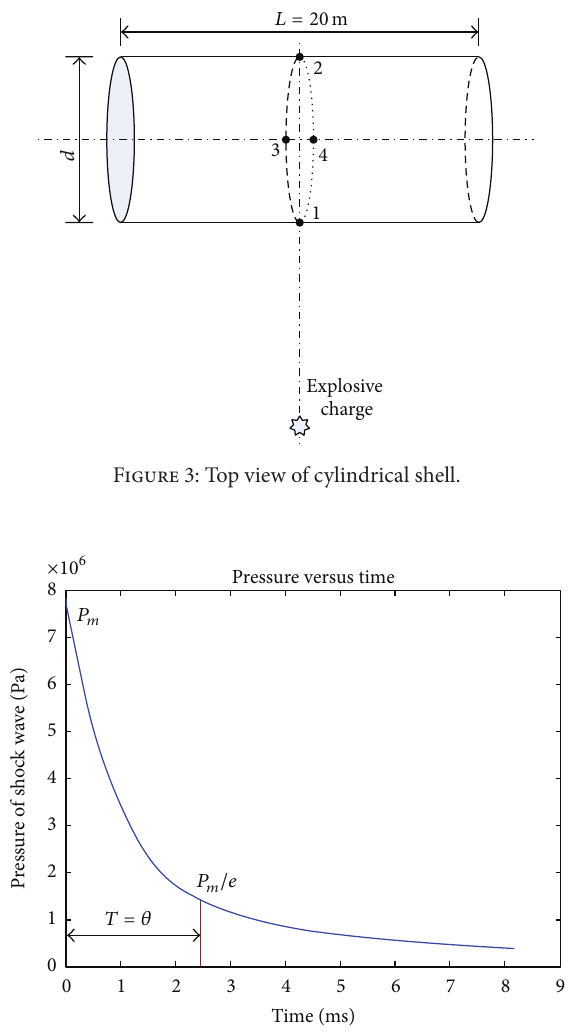
Figure 4: Incident wave with pulse